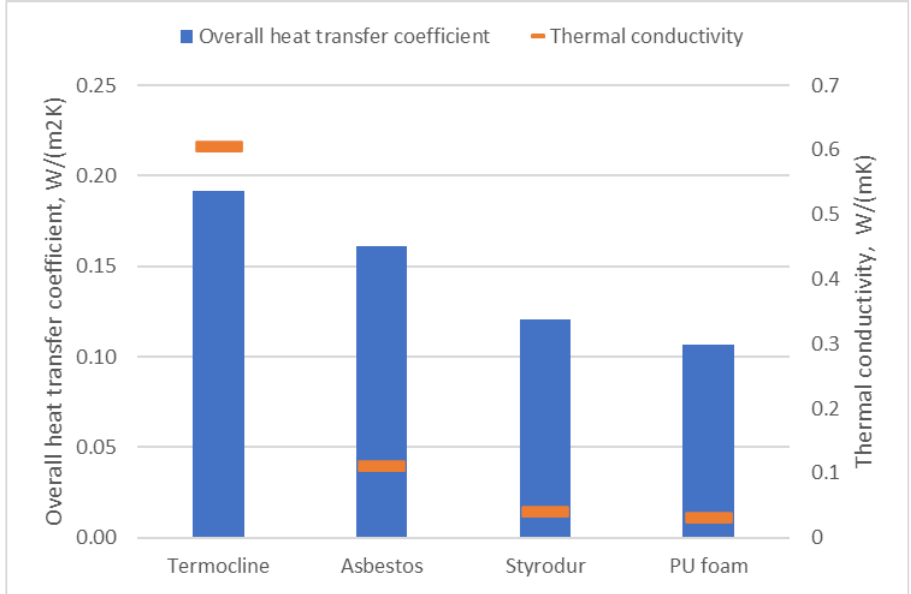
Figure 9. Comparison of overall heat transfer coefficient and thermal conductivity (assuming equal thickness of